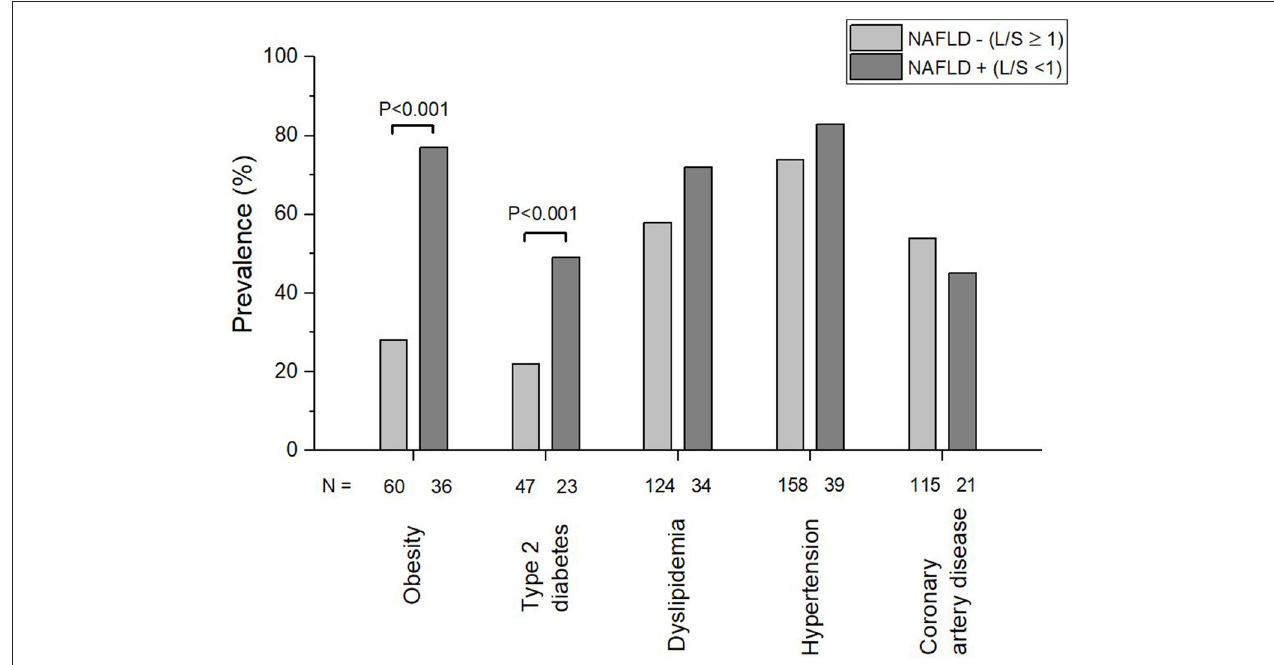
FIGURE 2 | Prevalence of obesity, Type 2 diabetes, dyslipidemia, hypertension, and coronary artery disease in subjects with non-alcoholic fatty liver disease (NAFLD + ) and without non-alcoholic fatty liver disease (NAFLD–). NAFLD was diagnosed using cut off value 1 for liver to spleen ratio (L/S) based on radiodensity values in low dose computed tomography scans.